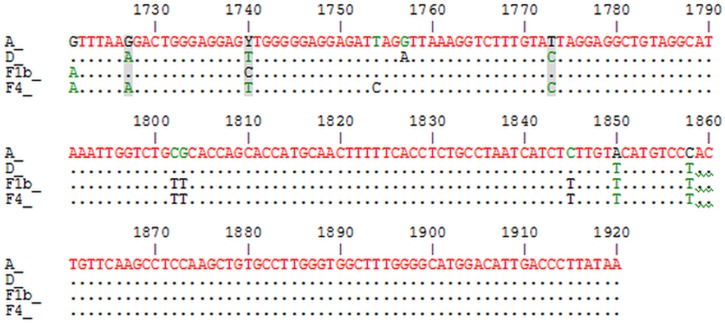
Alignment of consensus sequences spanning 1820 ± 100 nucleotide region of different genotypes.Non-identical nucleotides for genotypes A, D, F1b and F4 are shown. Nucleotides shared between genotype A and F1b are shaded.